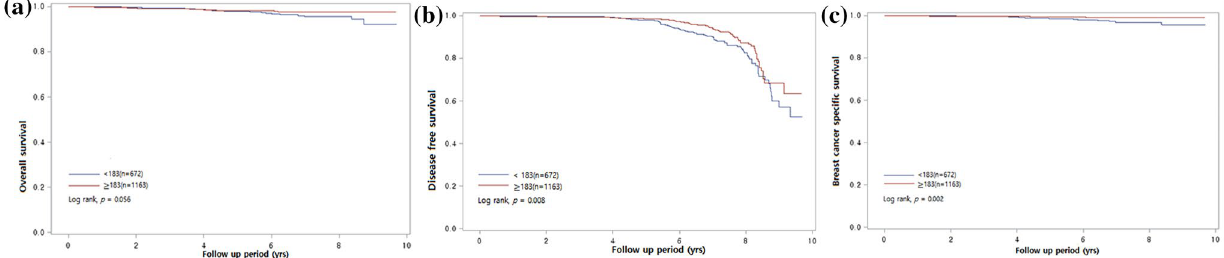
Fig. 3 Kaplan-Meier analysis of validation set 2 according to the cutoff of 183. a Overall survival. b Disease-free survival, and c Breast cancer- specific